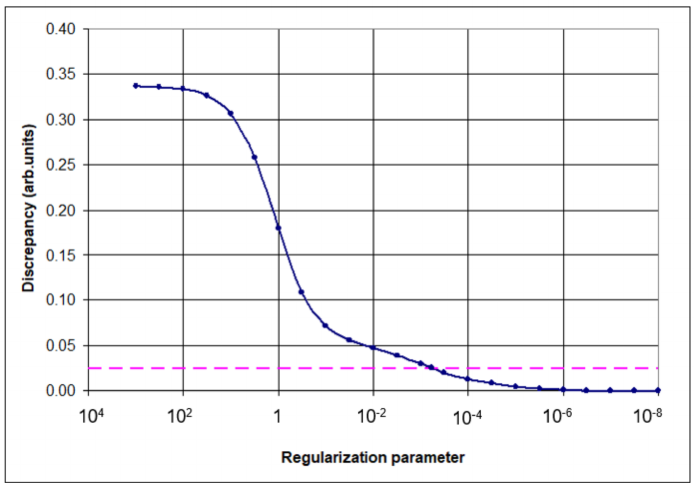
Figure 1. Dependence of the discrepancy between the experimental and calculated frequencies on the value of the regularization parameter α in the process of optimization. The choice of the regular- ization parameter in the optimization procedure is made according to the discrepancy principle [1,5] (dotted